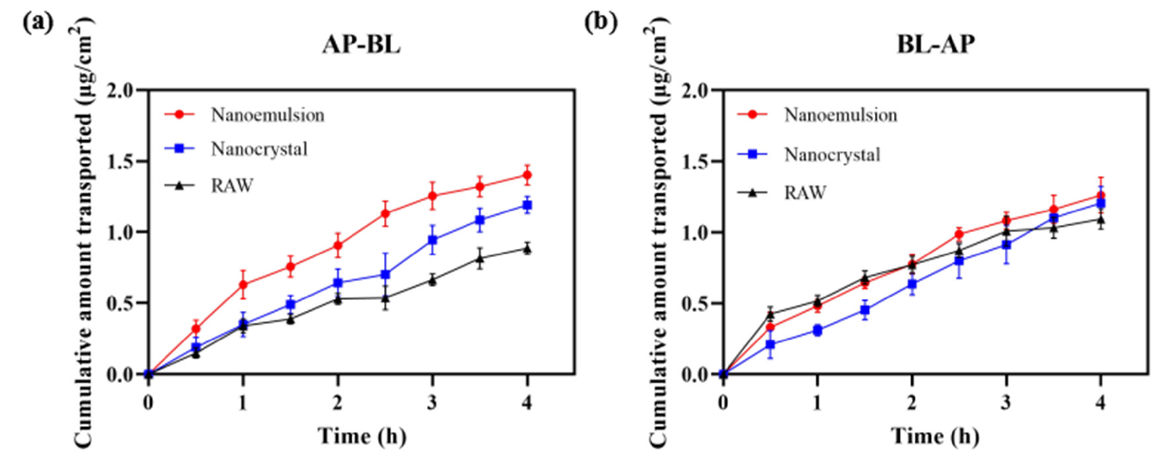
Figure 12. Cumulative transport capacity of different DAS samples in the direction of AP–BL ( a ) and BL–AP ( b ).